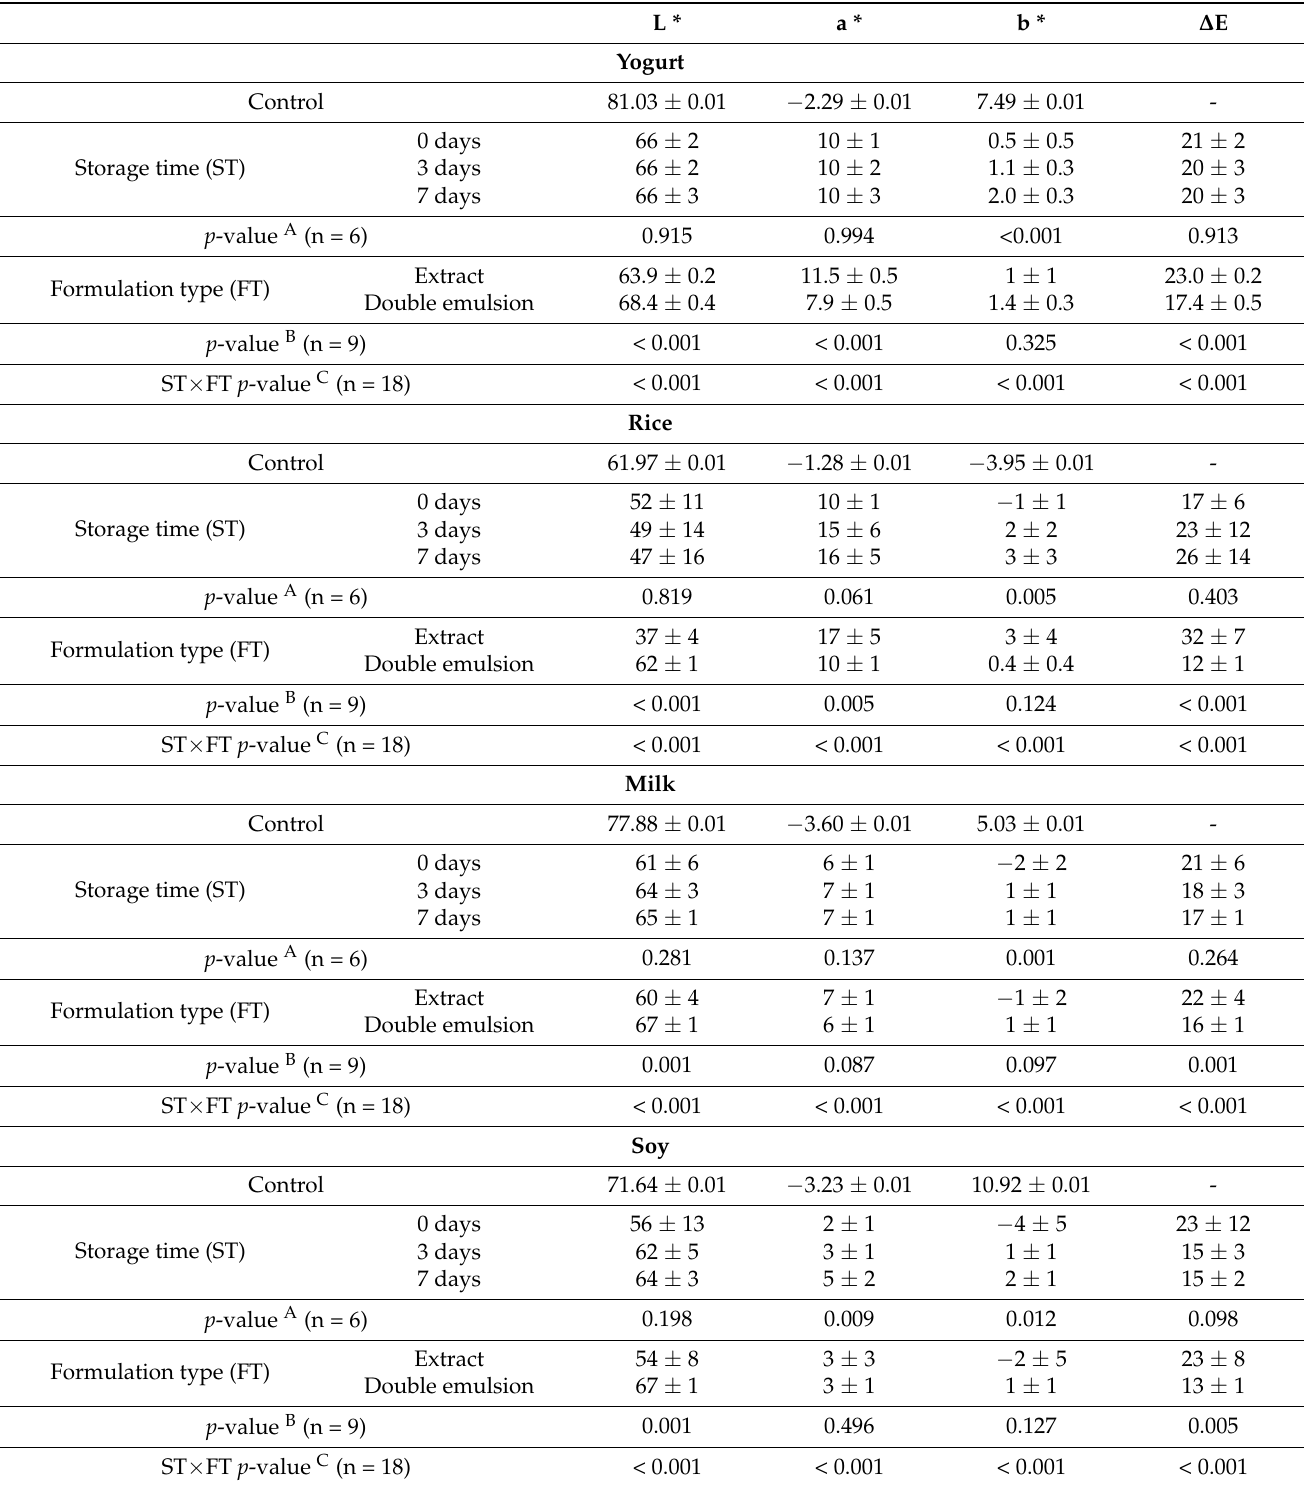
Table 3. Effect of different storage time and formulation type on the colorimetric parameters of the tested beverages stored at 23 ◦